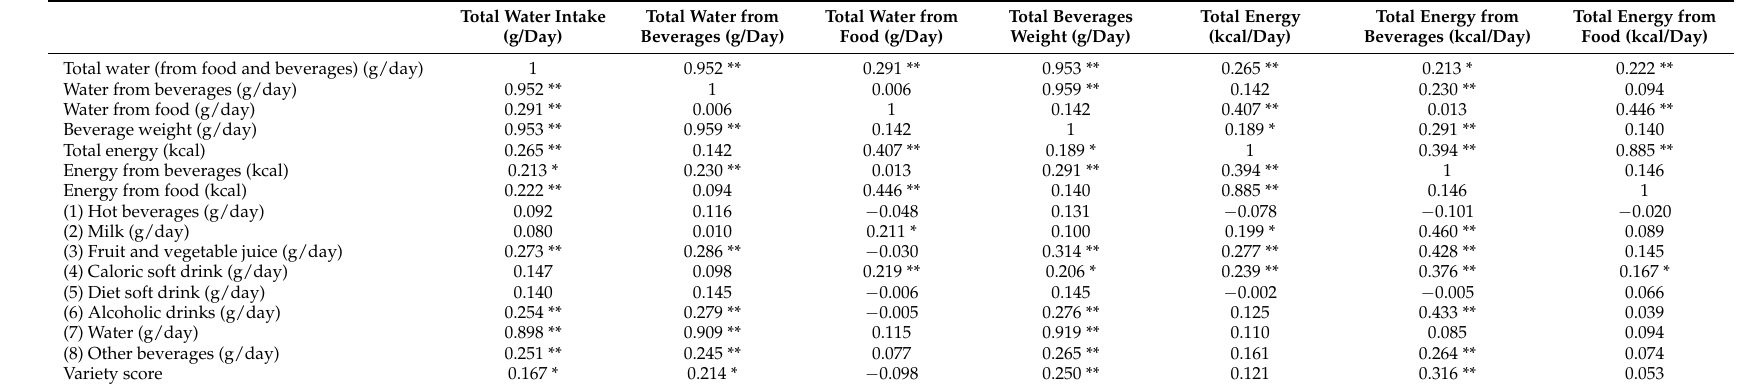
Table 8. Partial correlations between water intake, energy intake, and beverage consumption adjusted for age, gender, body weight, and activity from seven-day diaries ( n = 178).